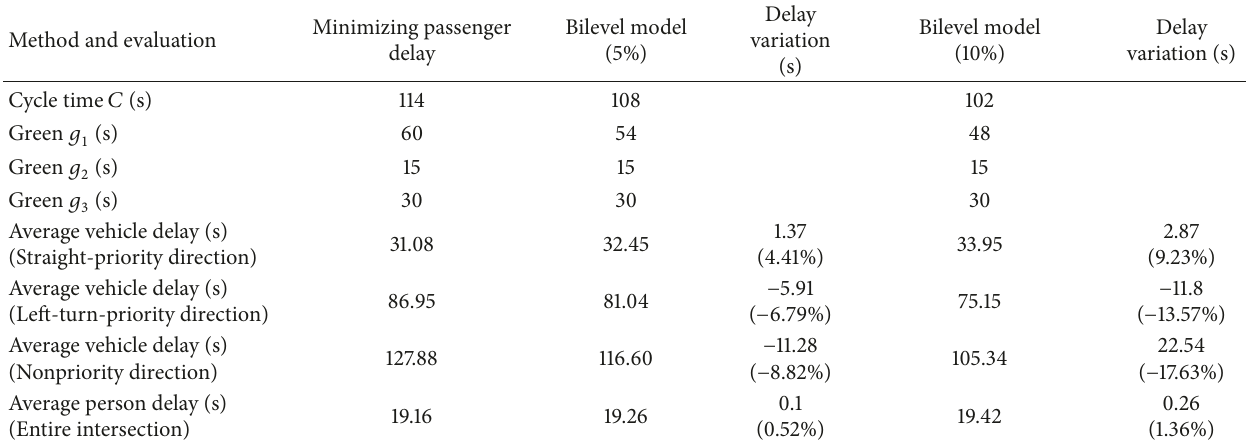
Table 2: The optimizing result compared with the conventional